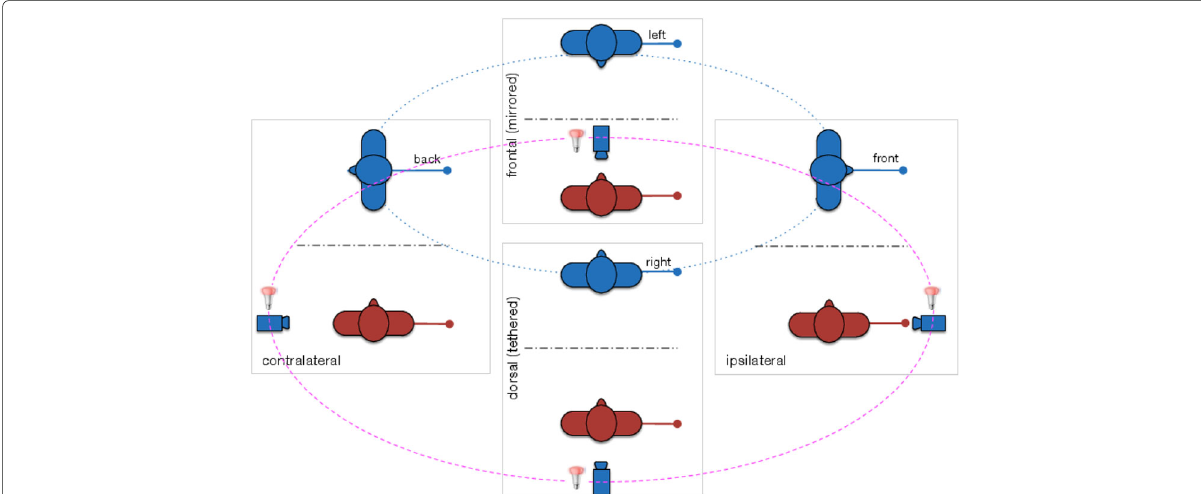
Fig. 18 This composite shows four frames from a wrapped cycle of an orbiting virtual camera (at 0 ◦ , 90 ◦ , 180 ◦ , and 270 ◦ ). The user twirls a poi -like affordance (shown as a knob-terminated segment), which is adaptively projected into the scene. For simplicity, the illustration uses a static actor and affordance position, simple “right pointing,” but typically the manipulable is whirled, even as the virtual camera moves. Each quadrant (delimited by grayrectangles ) associates a subject ( red,lower ) with a projection ( blue,upper ) through the graphical display (“ dot–dash ” segment). (“Real” things are shown in blue , “virtual” things in red , and “hybrid” things in purple .) The virtual camera sweeps around ( larger,purpleoval ), changing the perspective on the self-identified avatar ( smaller,blueoval ). A subtlety lies in the phase adjustment of the affordance’s image: in order to shift continuously between frontal, mirrored ( topcenter ) and dorsal, tethered ( bottomcenter ) perspectives, displayed azimuth of the object must be perturbed. Although the human actor frozen here in the diagram strikes a static pose across the camera angles, affordance projection is artificially rotated to accommodate the shifting perspective. Environmental lighting surrounding the player, iconified by the “light+camera”s in the figure, represents positions of the virtual camera projected back into user space, the perspective standpoint in the “real” world